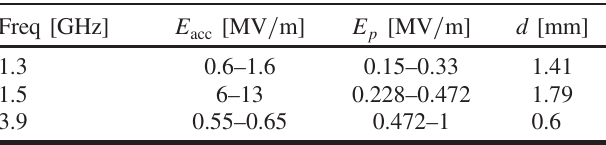
TABLE II. The zone 1 MP parameters of the ILC, CEBAF, 3.9 GHz cavities.